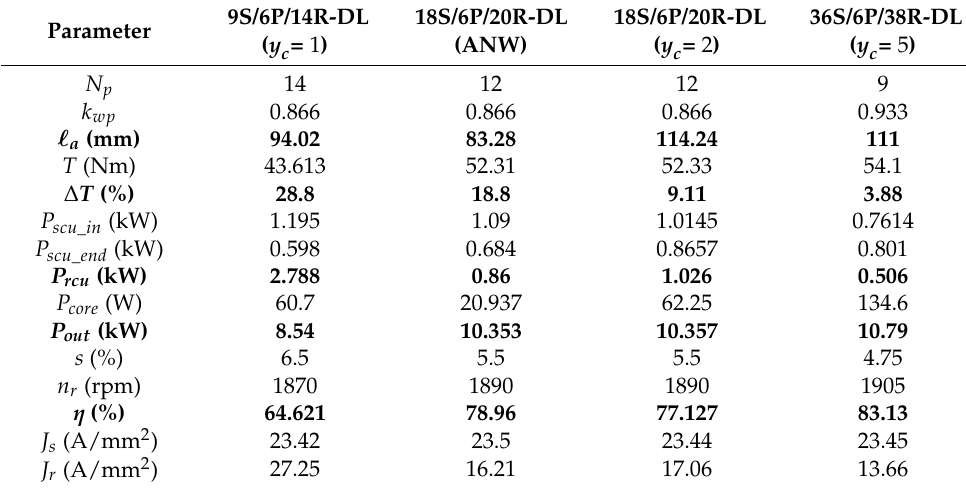
Table 3. Comparison of some parameters and key